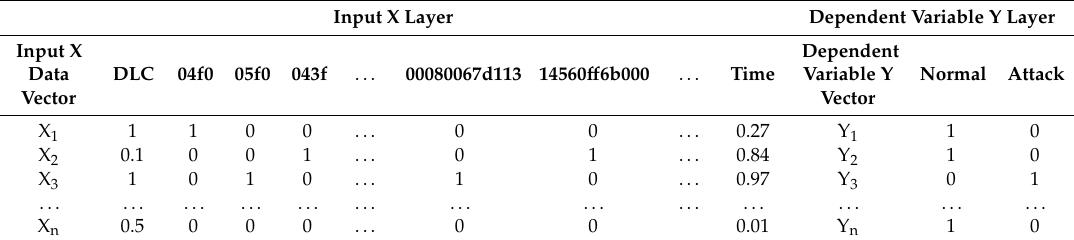
Table 3. Processed dataset.